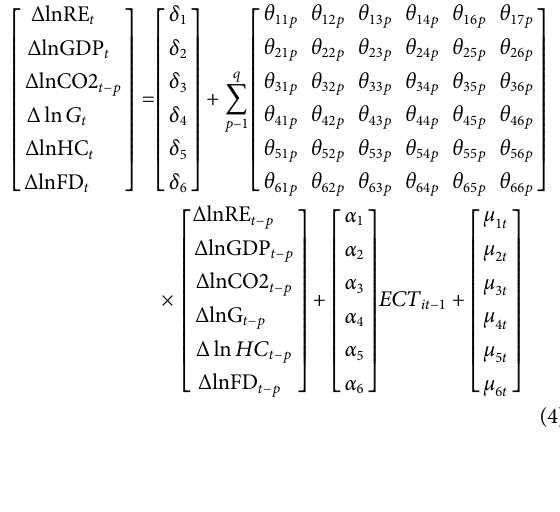
CUSUM. Figure 1, 2 show overall CUSUM values and squares of CUSUM values. The Residual values represent the blue line and the red line is the con fi dence level. These graphs show that the ARDL model is consistent and stable because the estimated values of the residues are within the 5% signi fi cance level within the con fi dence interval.